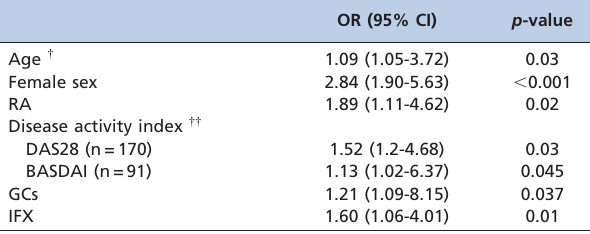
Table 4 - Final logistic regression model of the significant risk factors associated with CAEs in 257 patients with chronic inflammatory arthritis taking TNF- a blockers.